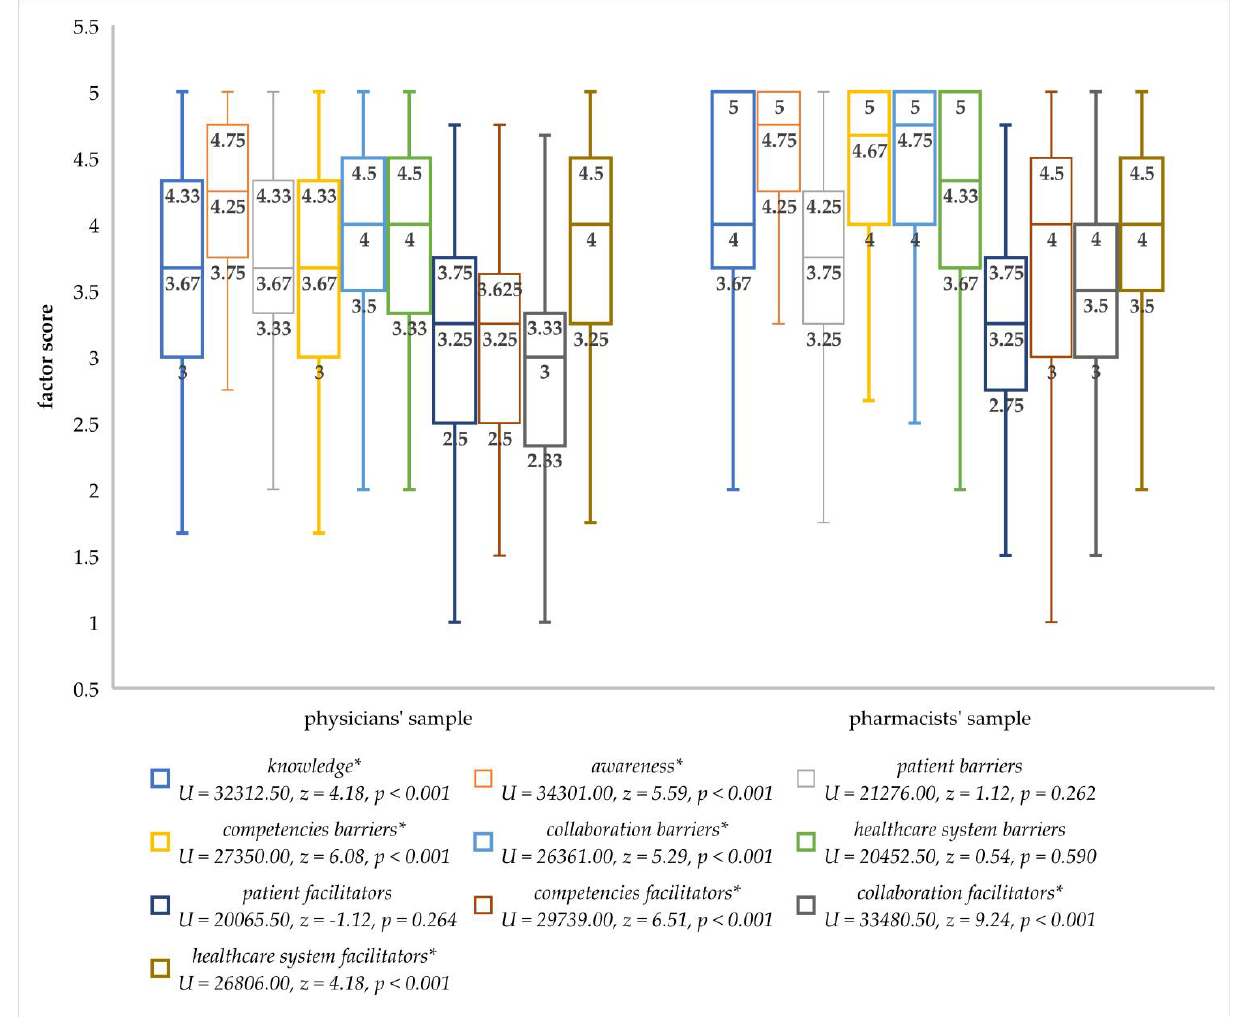
Figure 1 . Differences in factor scores between pharmacists and physicians (Mann – Whitney U